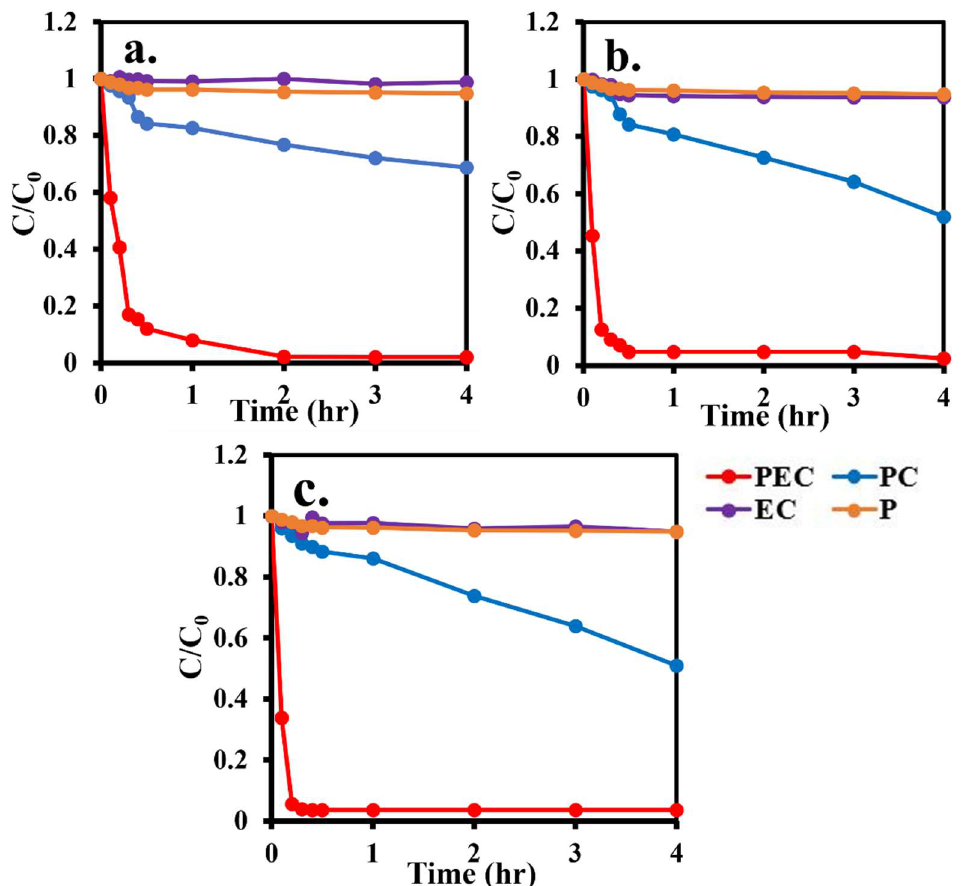
Figure 8. Comparison of methyl orange degradation in PEC, photocatalytic (PC), electrochemical (EC) and photolysis (p) processes by ( a )TNAs, ( b ) Fe/TNAs-0.2, and ( c ) Fe/TNAs-0.5 (light source: 100 W hg lamp, applied potential: +1.0 V (vs. Ag/AgCl), electrolyte: 10 ppm methyl orange in 0.1 M NaCl solution, reference electrode: Ag/AgCl, counter electrode: Pt wire, and working electrode: TNAs, Fe/TNAs-0.2, and Fe/TNAs-0.5).